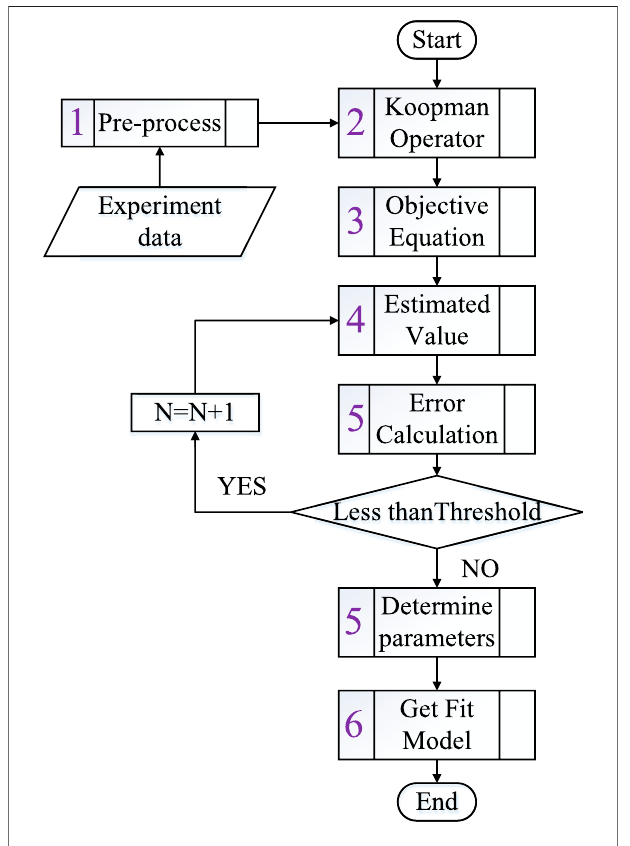
FIGURE 2 | The ML algorithm fl